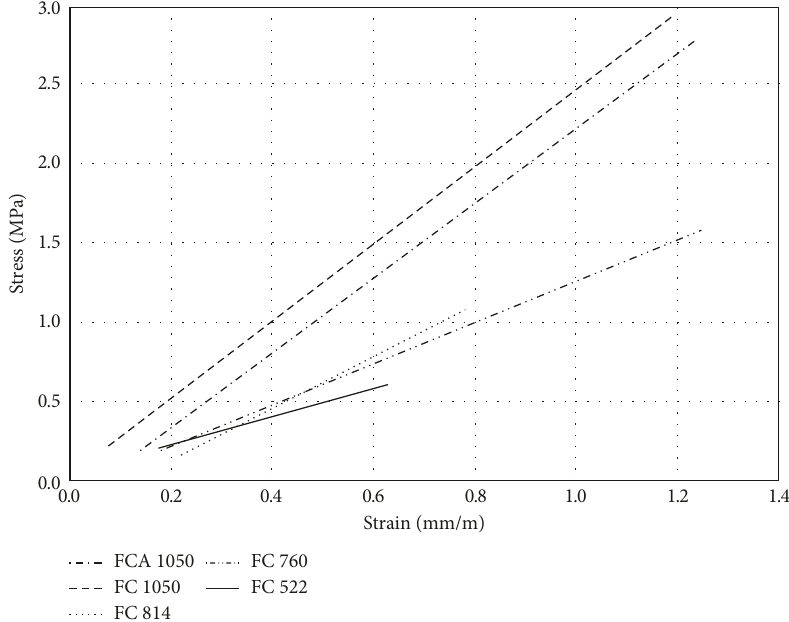
Figure 5: Stress-strain relationships of cylindrical specimens FC and FCA.